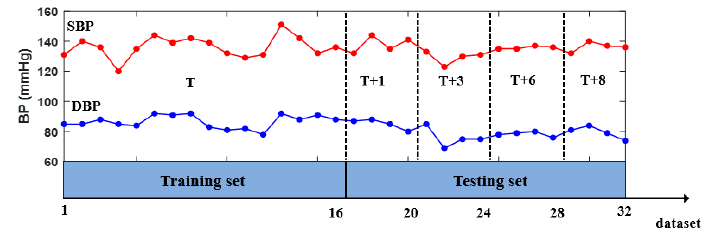
Figure 3. Experimental procedures at day T, T+1, T+3, T+6, and T+8.